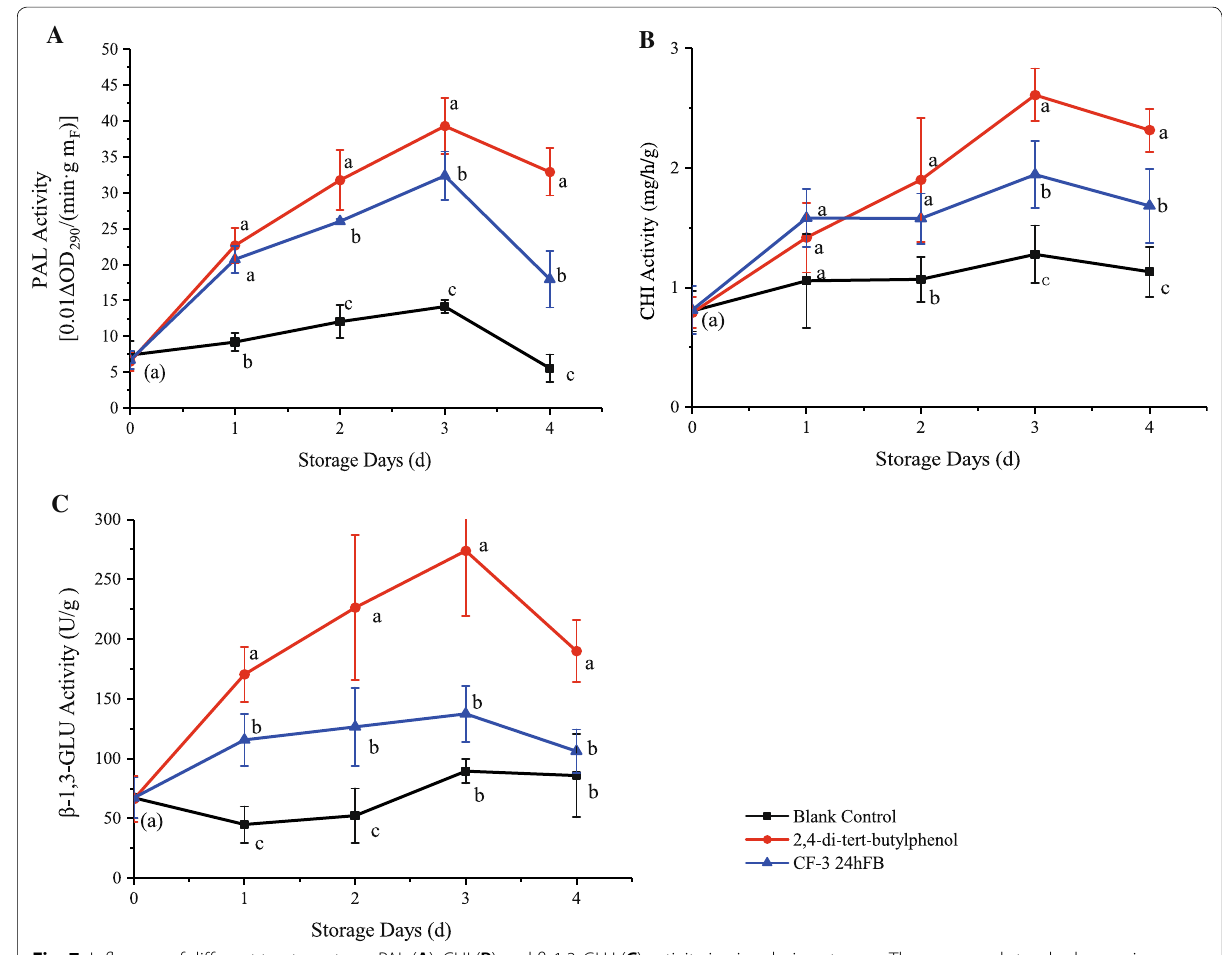
Fig. 7 Influence of different treatments on PAL ( A ), CHI ( B ) and β-1,3-GLU ( C ) activity in vivo during storage. The mean and standard errors in the figure were taken from three replicates, and different letters indicate that different treatments performed on the same storage days were significantly different ( P < 0.05 ) ( PAL phenylalanine ammonia lyase, CHI chitinase, β-1,3-GLU